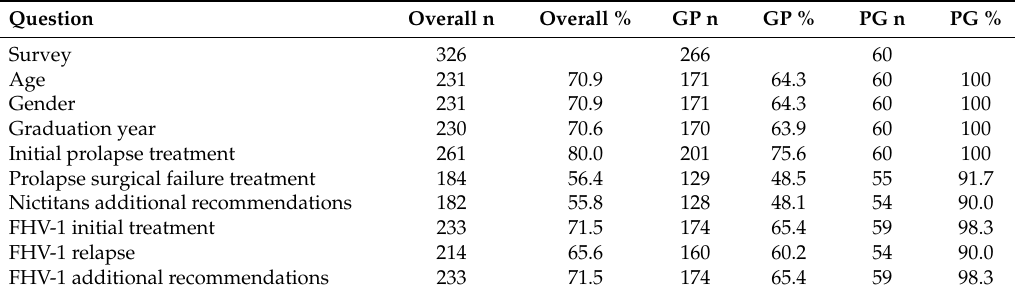
Table 1. Demographic and vignette question response